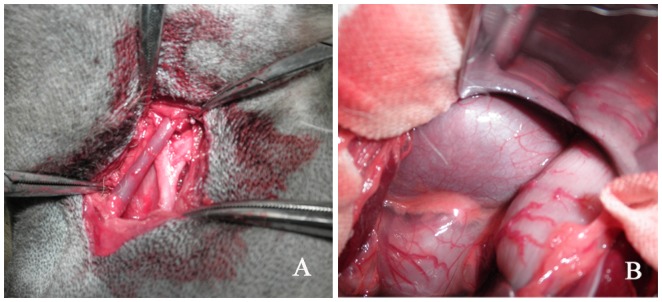
Representative images showing a stellate ganglion and renal hilum.A shows a star-shaped stellate ganglion behind the subclavian artery. B shows the renal hilum before dissection. The renal artery and renal sympathetic nerve enter the kidney through the renal hilum.